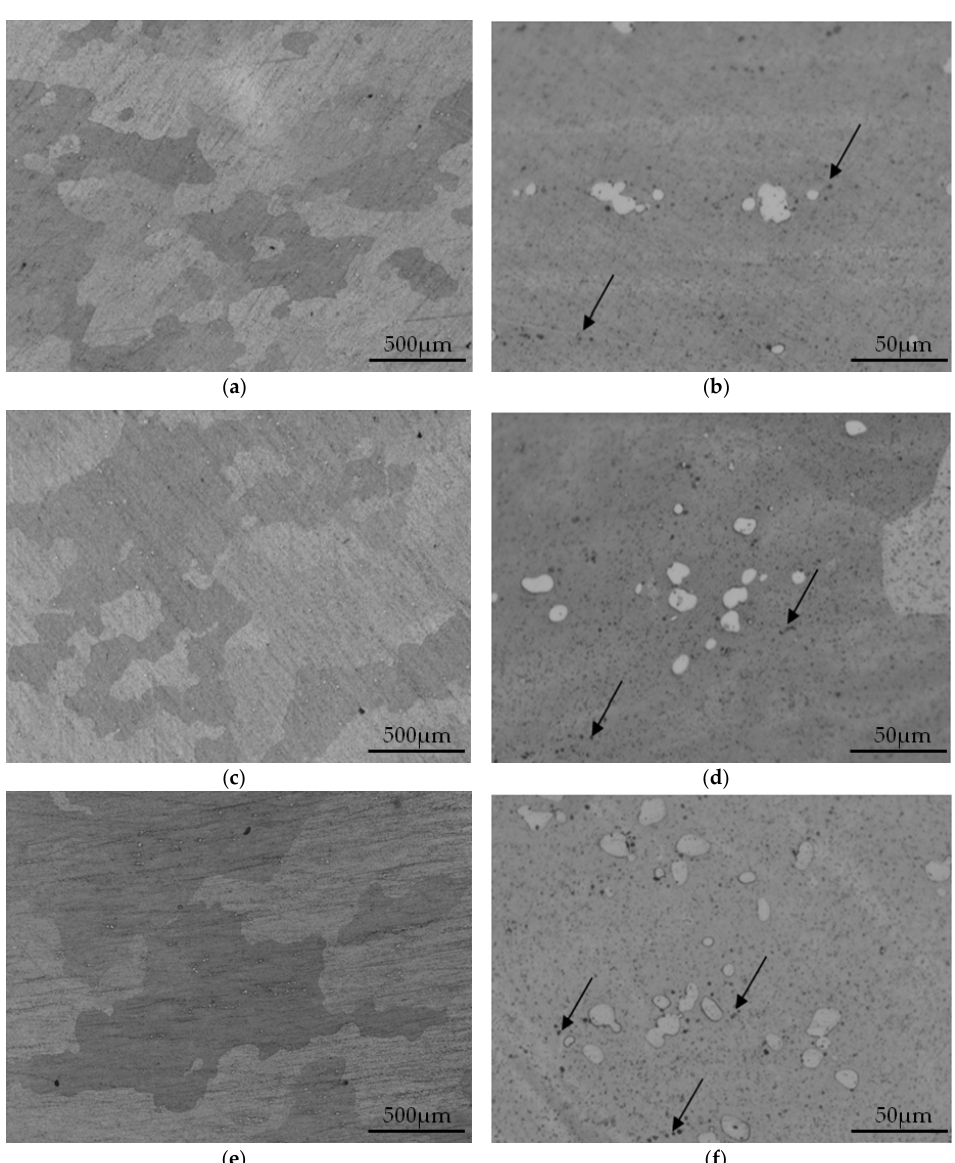
Figure 6. Optical micrographs of aging-2219 aluminum alloys with different Cu contents: ( a , b ) 5.56%, ( c , d ) 6.15%, ( e , f ) 6.52%.